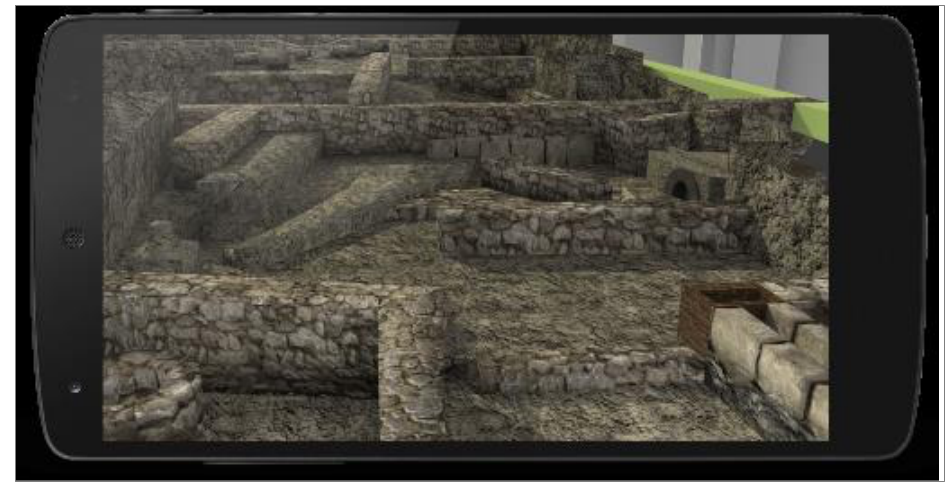
Figure 6 Layers of Different Periods (Finat et al. 2015).